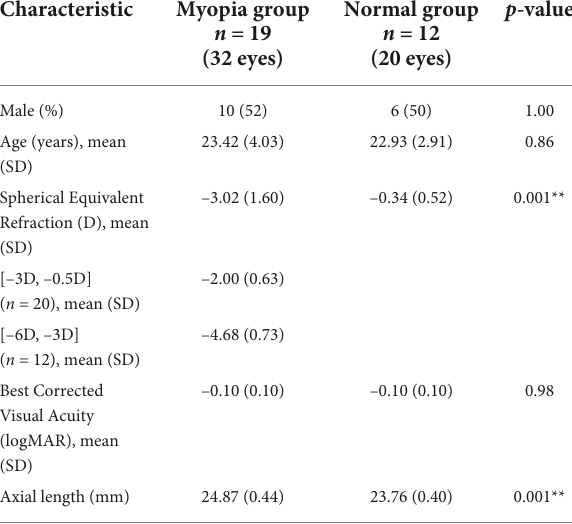
TABLE 1 Clinical characteristics of the